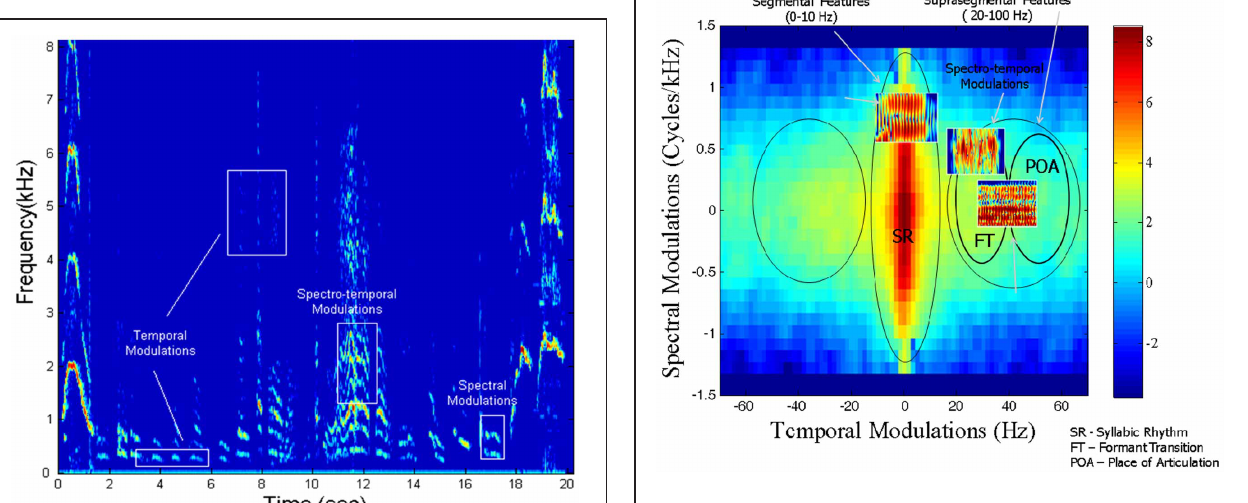
FIGURE 2 | Representative Modulation Spectrum derived from Spectrogram in Figure 1 by carrying out a 2-D Fourier decomposition, demonstrating the presence of articulatory features as a function of spectro-temporal